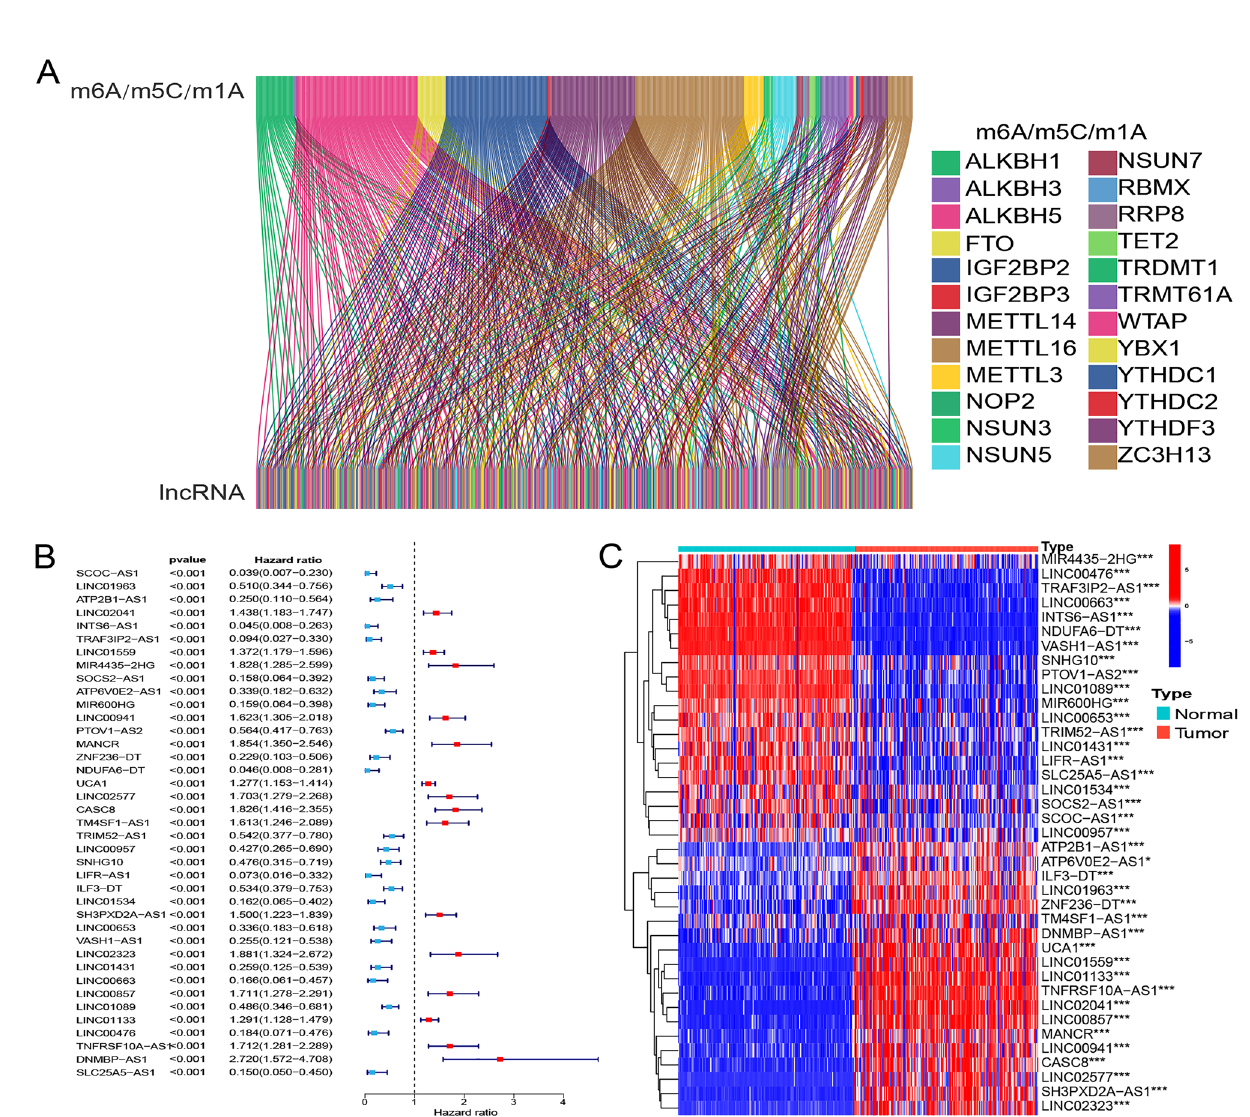
Figure 2. Filtering long non-coding (lnc)RNAs with prognostic potential for pancreatic cancer from a larger pool of methylation-associated lncRNAs.*, **, ***, represent P < 0.05, P < 0.01 and P < 0.001. ( A ) Sankey diagram of co-expression between m6A/m5C/m1A methylation types and lncRNAs. ( B ) Forest plot of 39 prognosis- related lncRNAs. ( C ) Heatmap of prognosis-related lncRNAs in pancreatic cancer samples and normal pancreatic tissue